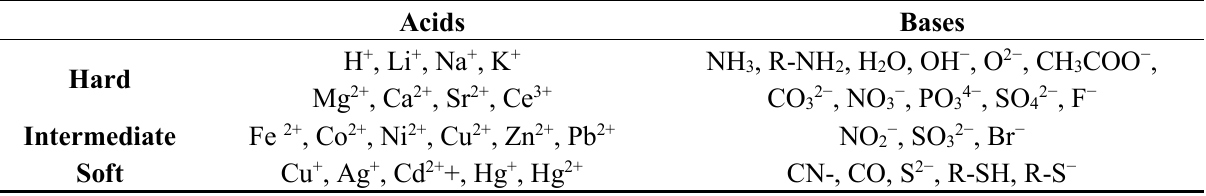
Table 1. Distribution of Lewis acids and Bases of common metals and ligands in the low-temperature geochemical environment (Modified after